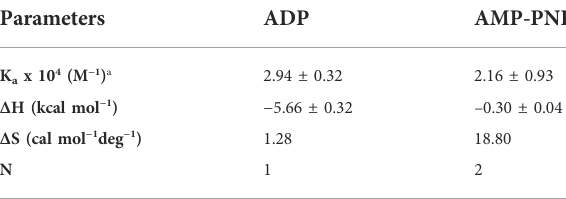
TABLE 1 Thermodynamic binding parameters of HtpG Mtb obtained with ADP and AMP-PNP titration by ITC at 22 ° C and pH 7.4. Parameters